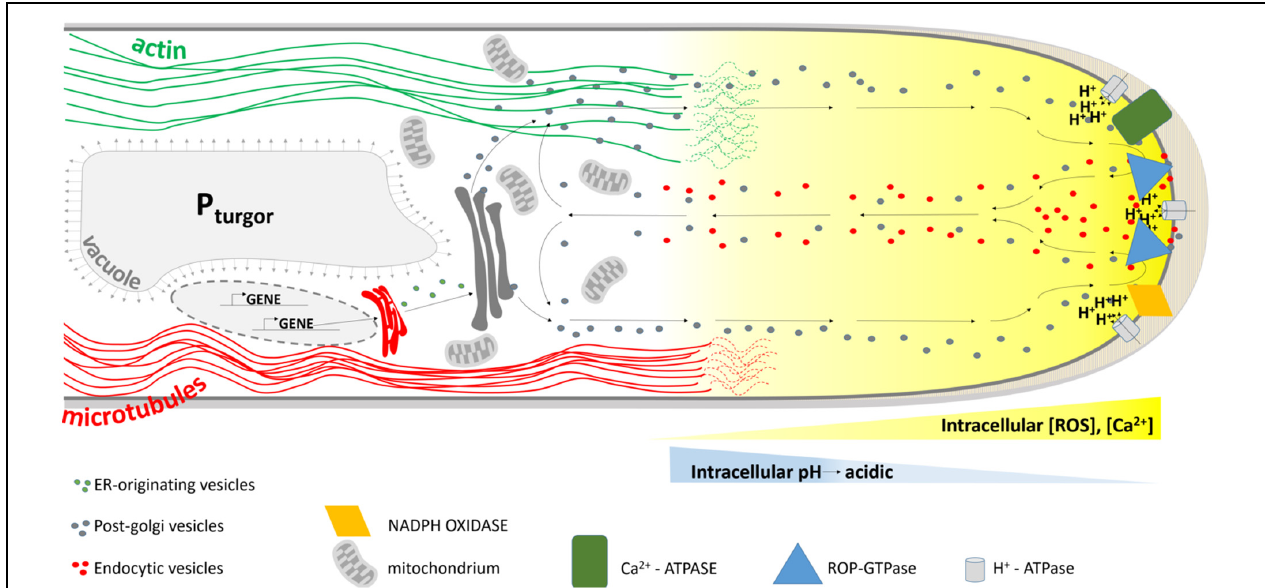
FIGURE 5 | Schematic representation of the cytoarchitecture within the growing root hair apex. The tip is packed with membrane-bound vesicles originating from the ER and Golgi apparatus delivering new cell wall material to the growing tip. Together with endocytotic vesicles that are formed at the extreme tip they display a reverse fountain streaming. ROP proteins are predominantly localized to the tip, together with hyperpolarization-activated Ca 2 + -ATPases and NADPH oxidases. The latter are responsible for the formation of a tip-focused calcium and ROS gradient (yellow gradient). A tip-focused pH gradient is also present. Microtubules (red lines) run along the length of the hair and control the hair’s growth direction, whereas actin cables (green) allow for polar vesicle